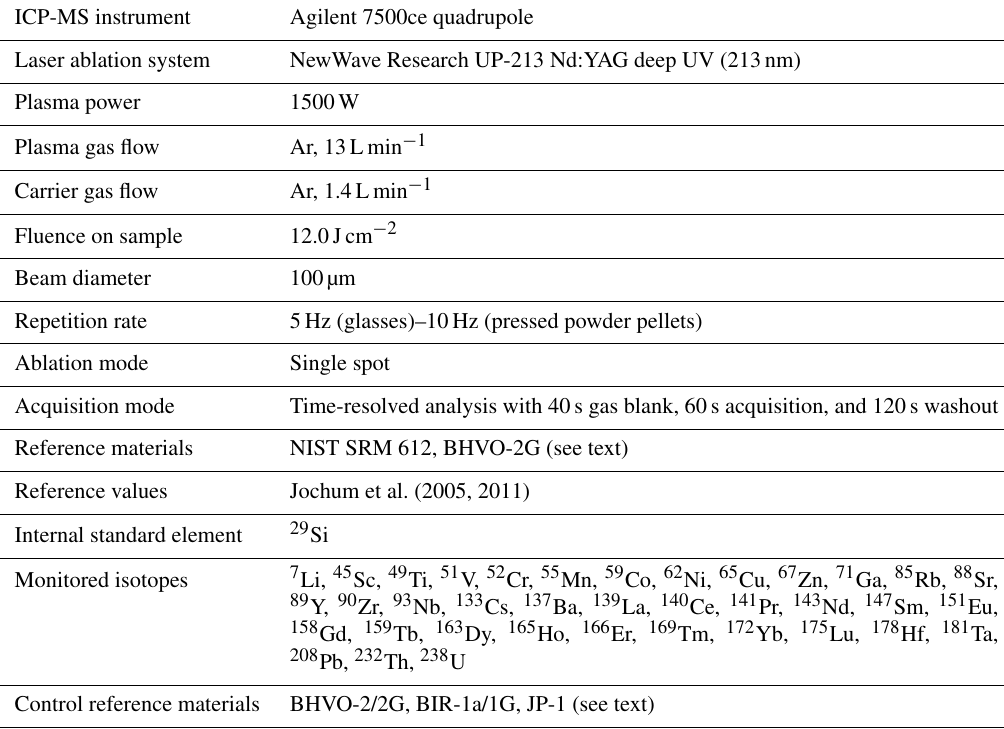
Table 1. Summary of the LA-ICP-MS instrument operating